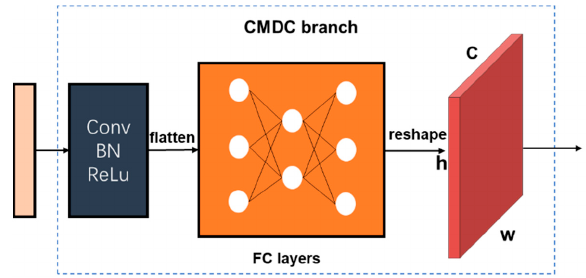
Figure 8. The structure of the CMDC branch.